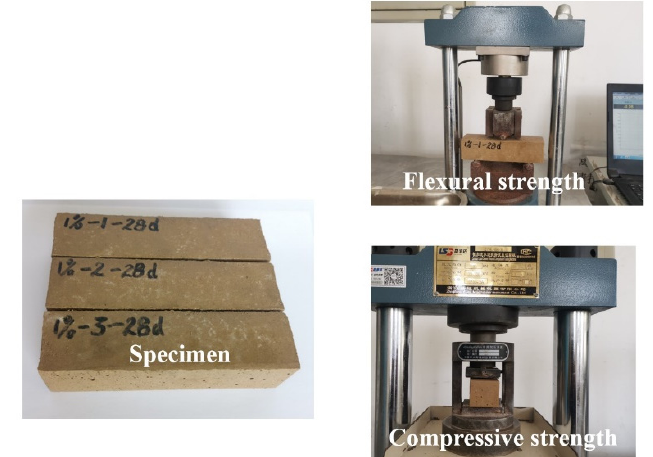
Figure 1. The process of measuring mechanical strength.